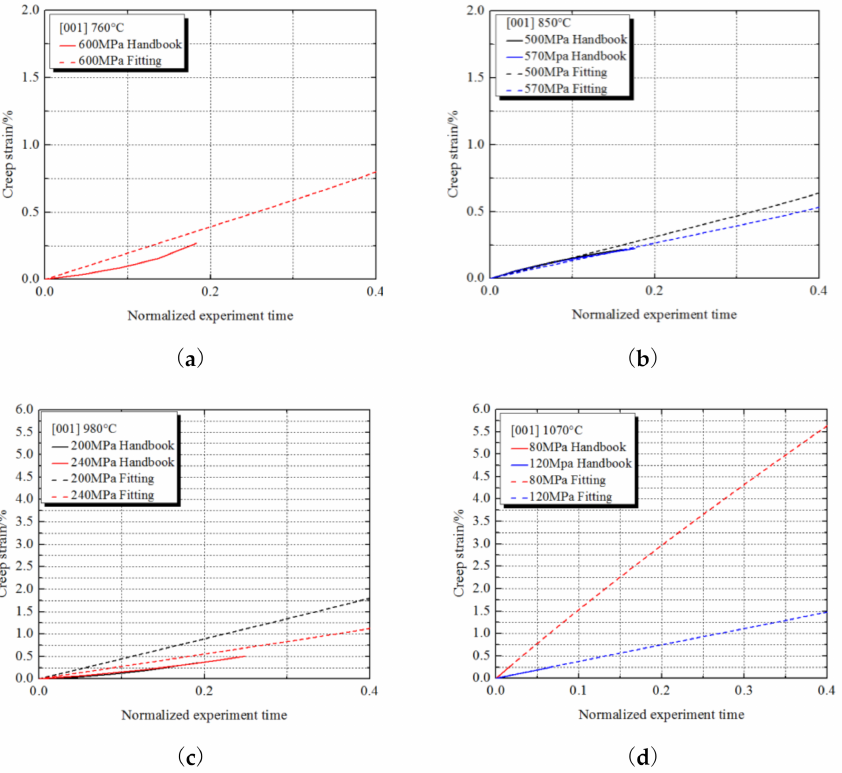
Figure 3. Normalized creep curve fitting results of [001] orientation. ( a ) [001] 760 ◦ C, ( b ) [001] 850 ◦ C,